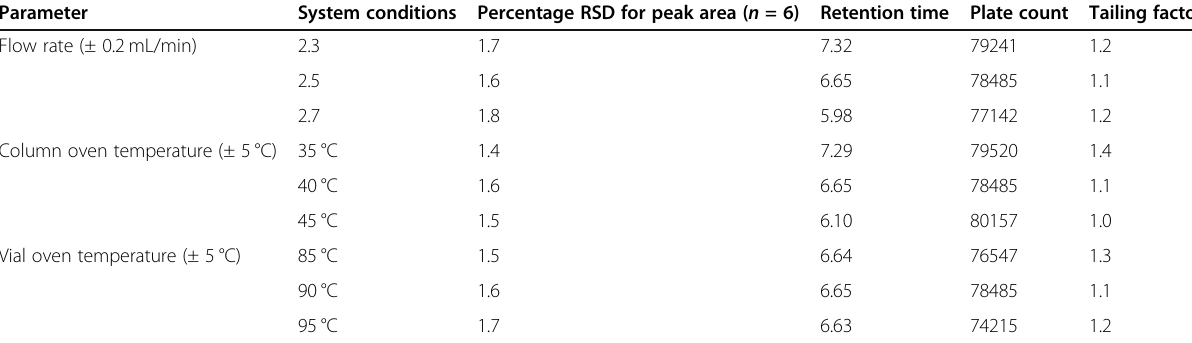
Table 20 Robustness study results of ethanol Parameter